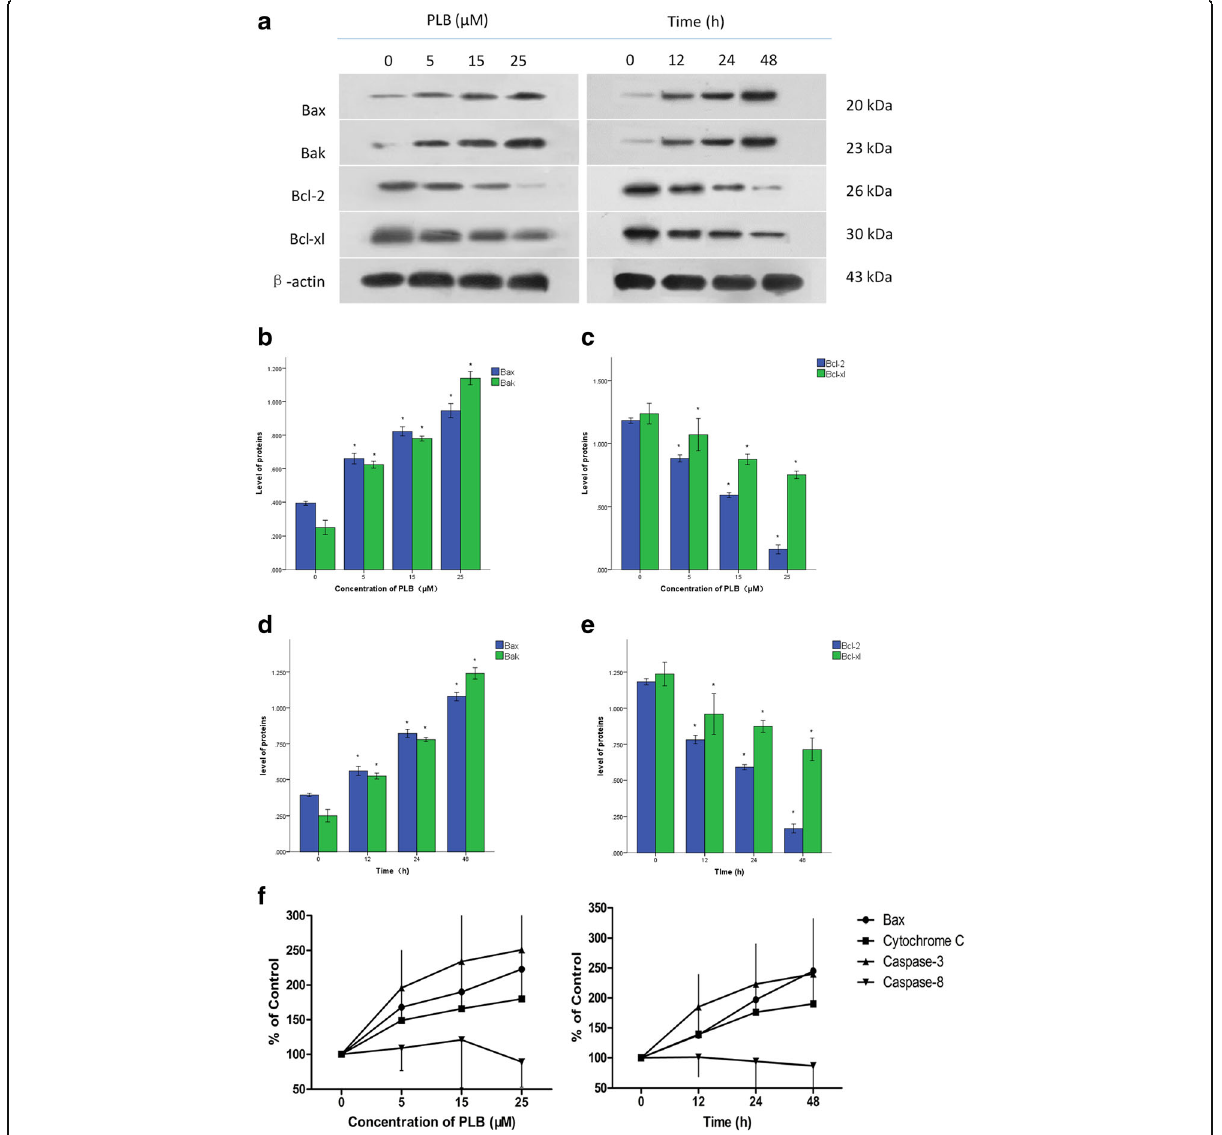
Fig. 4 Effect of plumbagin on the expression of apoptosis-related proteins in ARPE cells. (*: P < 0.05 by one-way ANOVA, n = 3). Notes: ( a ) The expression levels of Bax, Bak, Bcl-2 and Bcl-xl determined by Western blotting assay when ARPE cells were treated with plumbagin at 0,5,15 and 25 μ M. β -actin was used as the internal control. b Bar graphs show the expression levels of Bax and Bak when ARPE cells were treated with plumbagin at 0,5,15 and 25 μ M for 24 h. c Bar graphs show the expression levels of Bcl-2 and Bcl-xl when ARPE cells were treated with plumbagin at 0,5,15 and 25 μ M for 24 h. d Bar graphs show the expression levels of Bax and Bak when ARPE cells were treated with plumbagin at 15 μ M for 0, 12, 24 and 48 h. e Bar graphs show the expression levels of Bcl-2 and Bcl-xl when ARPE cells were treated with plumbagin at 15 μ M for 0, 12, 24 and 48 h. f The expression levels of Bax, Cytochrome C, Caspase-3 and Caspase-8 determined by ELISA when ARPE cells were treated with plumbagin at 0,5,15 and 25 μ M for 48